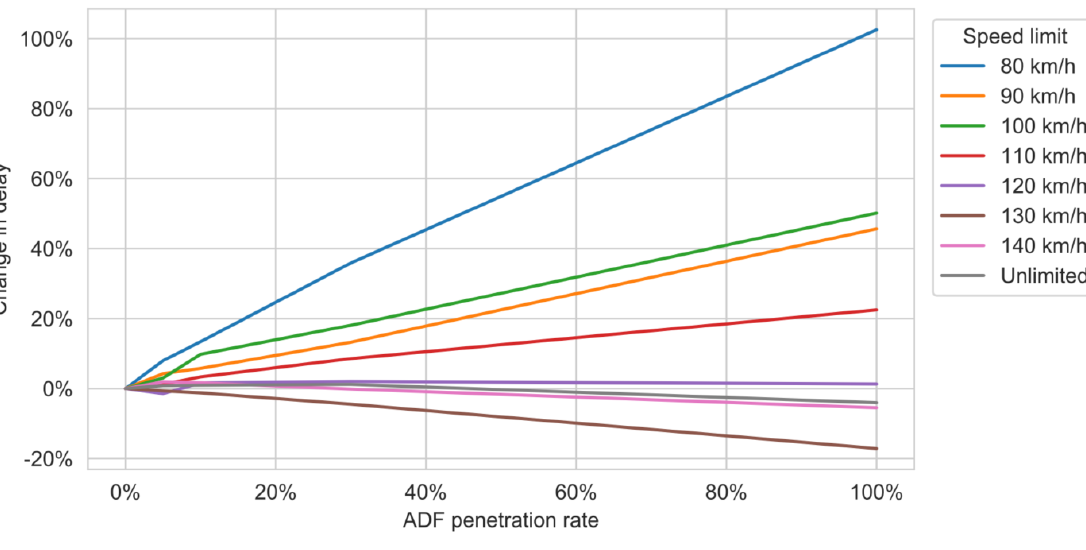
Figure 14. Scaled-up results with relative changes in delay at AV penetration rates of 5%, 10%, 30% and 100% among passenger cars compared to the baseline at different speed limits